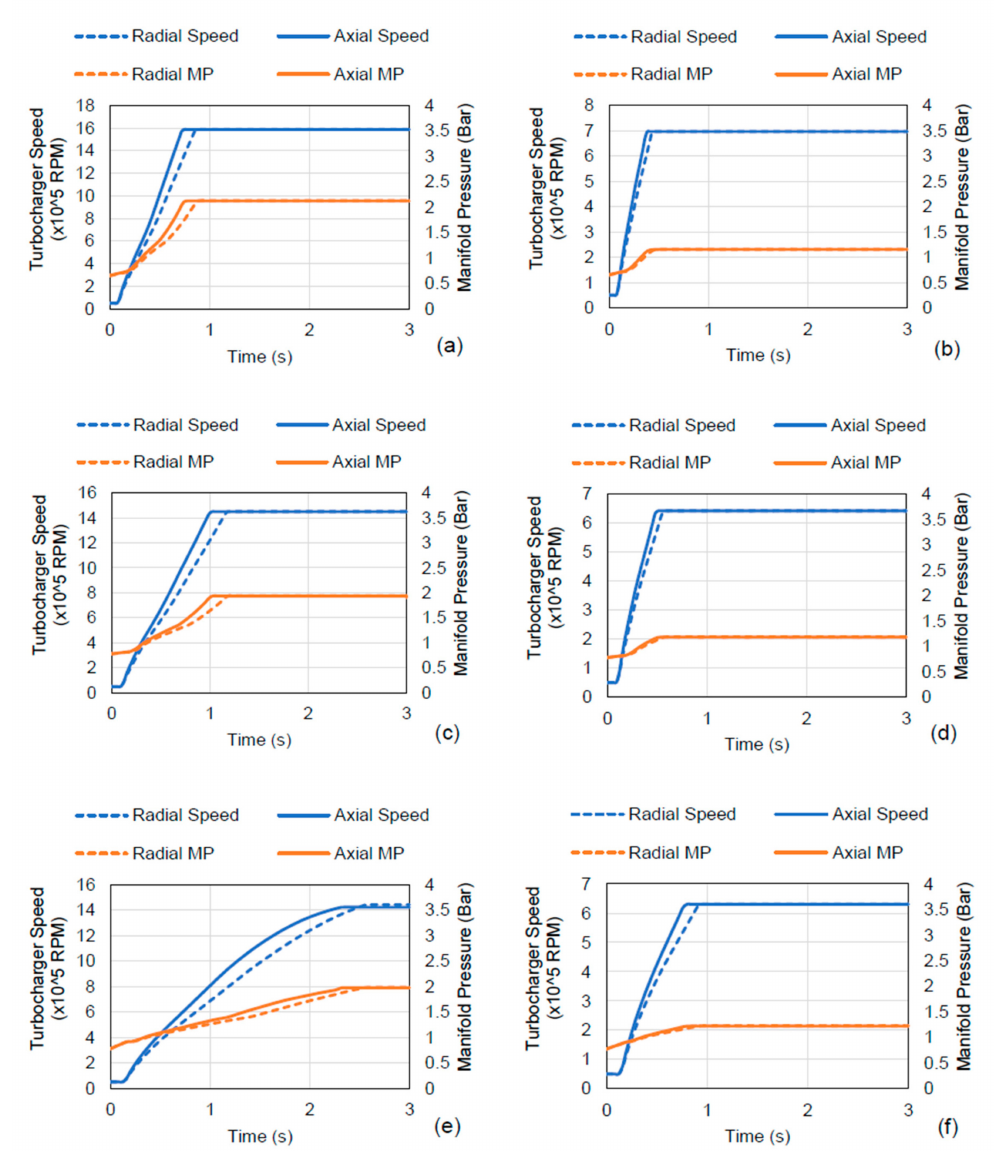
Figure 32. Transient response profiles for turbocharger shaft speed and manifold pressure at engine speeds of 5000 rpm ( a , b ), 4000 rpm ( c , d ), and 3000 rpm ( e , f ) at 100% (left) and 60% (right) engine loads.